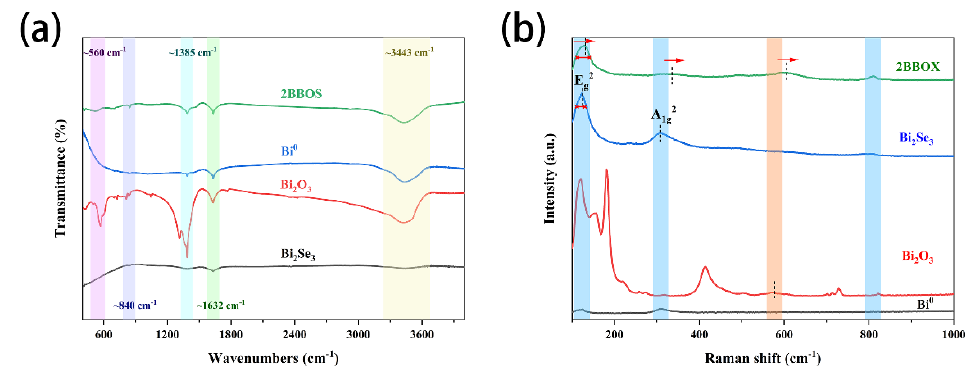
Figure 2. ( a ) FT–IR patterns and ( b ) Raman spectra of Bi 0 , Bi 2 Se 3 , Bi 2 O 3 and 2BBOS samples.